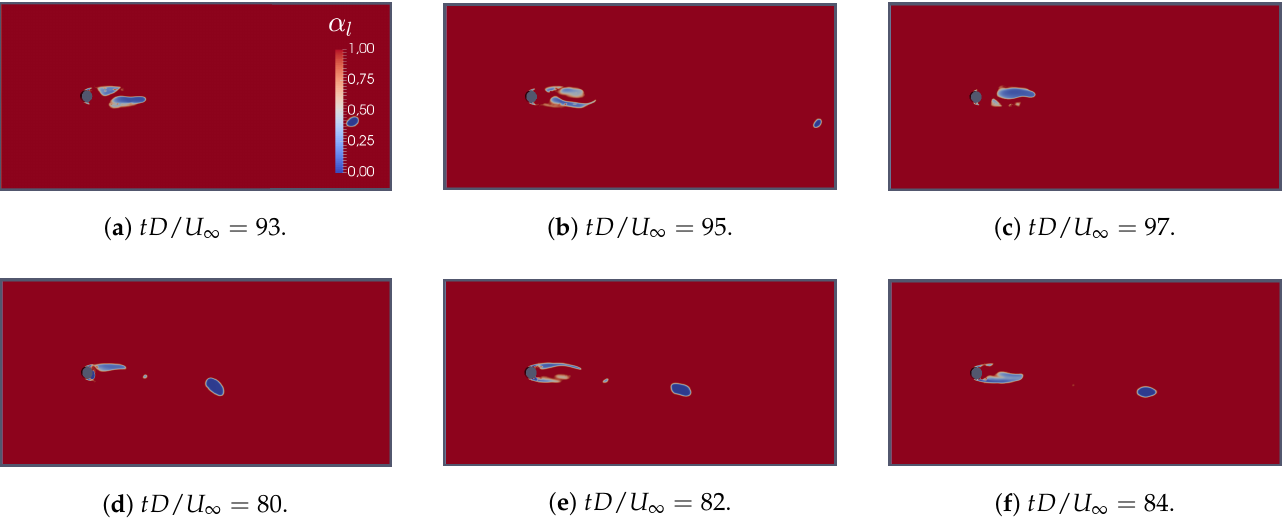
Figure 15. Contour plot of instantaneous liquid fraction, results obtained with Merkle model and considering analytical- based coefficients (Table